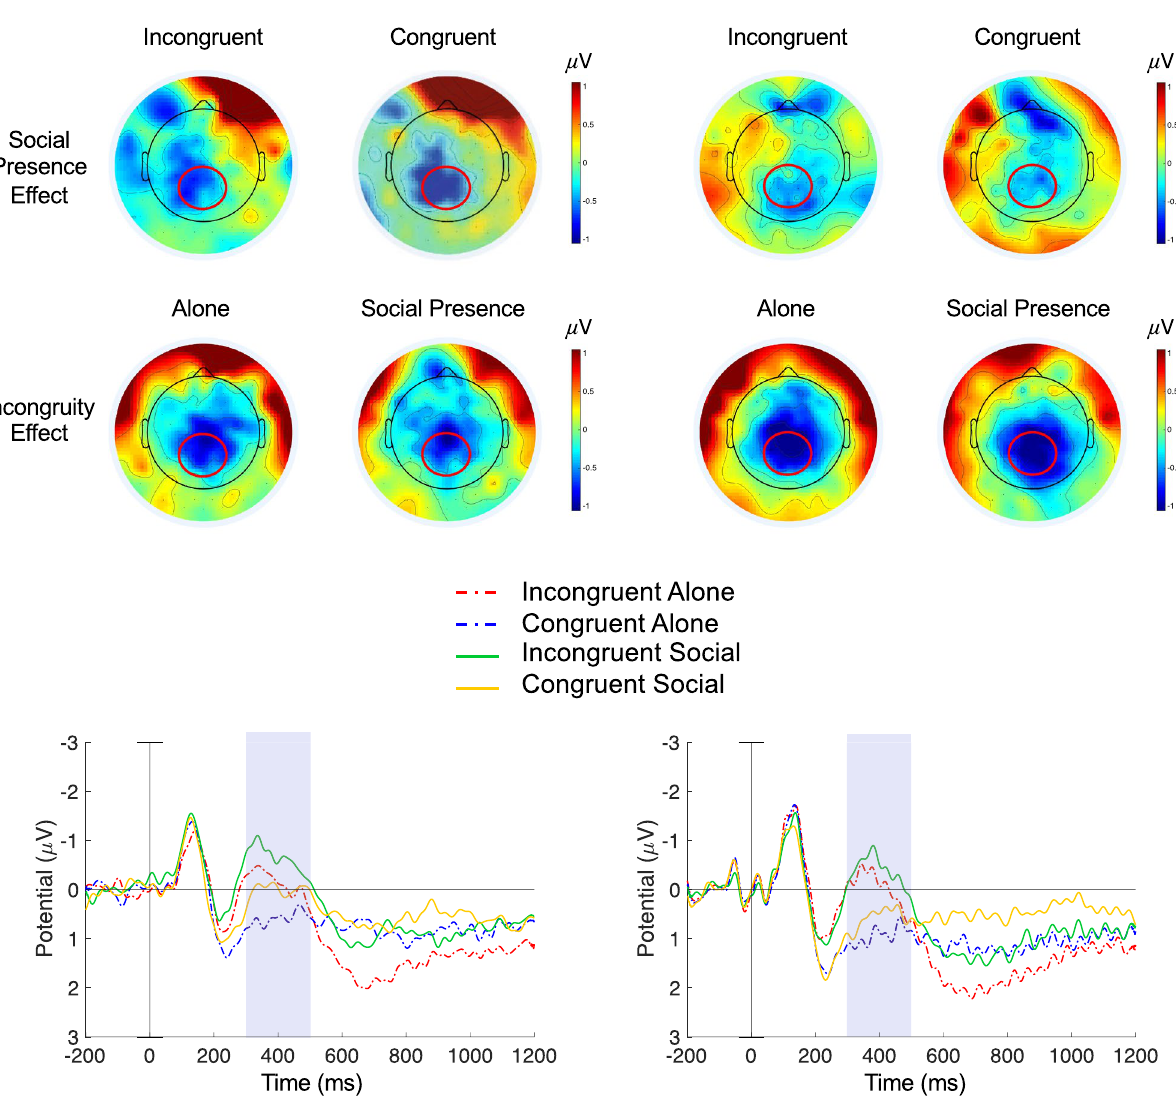
Figure 1. Electrophysiological responses observed in Experiment 1 & 2, evoked by semantic processing either in the presence or in the absence of a confederate. The left side shows results for the live presentation used in Experiment 1, and the right side shows result for the video presentation used in Experiment 2. Upper panels show topographical difference maps in the N400 time window (300–500 ms), where Social Presence Effect denotes a Social Presence–Absence difference, visualized for Congruent and Incongruent conditions separately; the Incongruity Effect denotes an Incongruent–Congruent difference, visualized separately within Social Presence and Alone conditions. Red circles mark a predefined frontal and centro-parietal Region-of-Interest (ROI). Lower panels show grand average ERP responses averaged over individuals and electrodes within each ROI. Time 0 is the onset of auditory word playback. Grey shades indicate N400 time windows where statistical analyses were carried out. Both a typical semantic Incongruity (N400) and a Social Presence effect, an enhanced electrophysiological negativity in the 300–500 ms time window over the centroparietal ROI are apparent in both experiments. The N400 response seems to be sensitive no only to semantic incongruities, but also to the mere presence of social partners. Perhaps it indicates the activation of a broader range of possible senses and meanings that the other person could have in mind, enabling rapid and fluent adjustments of the common ground, arriving at implied meanings and agreeing on what was meant by what was said. The finding suggests that the language system might be an integral part of mentalistic social-cognitive neural